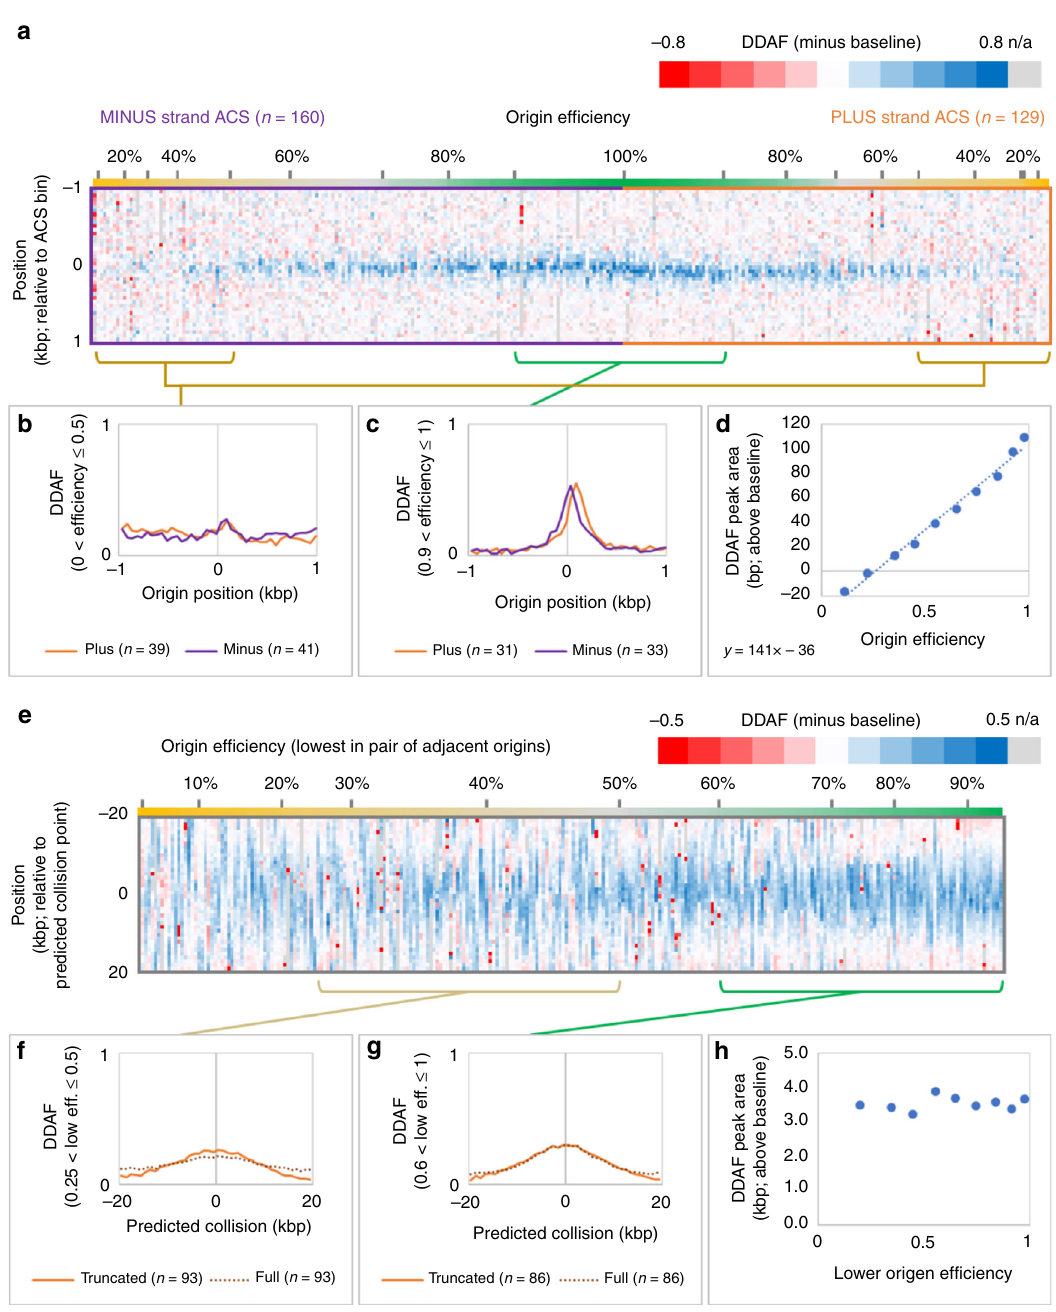
Fig. 3 DDAF peaks at replication origins and termination zones in S. cerevisiae . a A DDAF heatmap in 50 bp bins for one kilobase on either side of 289 replication origins (green bars in Figs. 1d and S2). Origin motifs (ACS motifs) on the plus (top) strand are grouped as “ plus strand ACS ” and minus (bottom) strand oriented origins are gouped as “ minus strand ACS ” . Origins are ranked by ef fi ciency. Blue indicates a high DDAF value (less Pol ε usage), red denotes the opposite. b Averaged DDAF value at inef fi cient origins (ef fi ciency < 0.5). Orange curves are for plus strand origins and purple curves are for minus strand origins. The number of origins used is indicated. c Averaged DDAF value at ef fi cient origins (ef fi ciency > 0.9). d DDAF peak areas (after baseline subtraction) increase linearly with origin ef fi ciency ( R 2 = 0.986). The negative value at origin ef fi ciency of zero is due to aggressive background subtraction (see the “ Methods ” section). e As per a but in 1000 bp bins for 20 kb on either side of predicted collision points (red bars in Figs. 1d and S2) for forks proceeding from 259 well-separated adjacent origins (distance ≥ 20 kb). The heatmap is ranked by the ef fi ciency of the lesser ones of the pairs